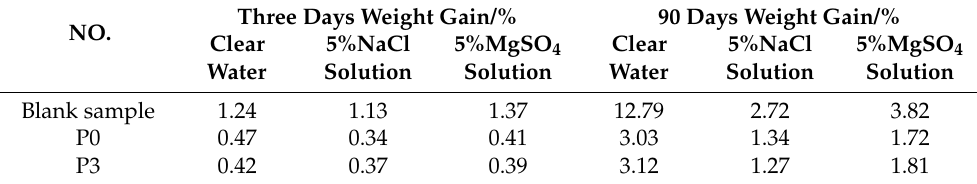
Table 4. Chemical erosion resistance of the MMA repair material. NO.